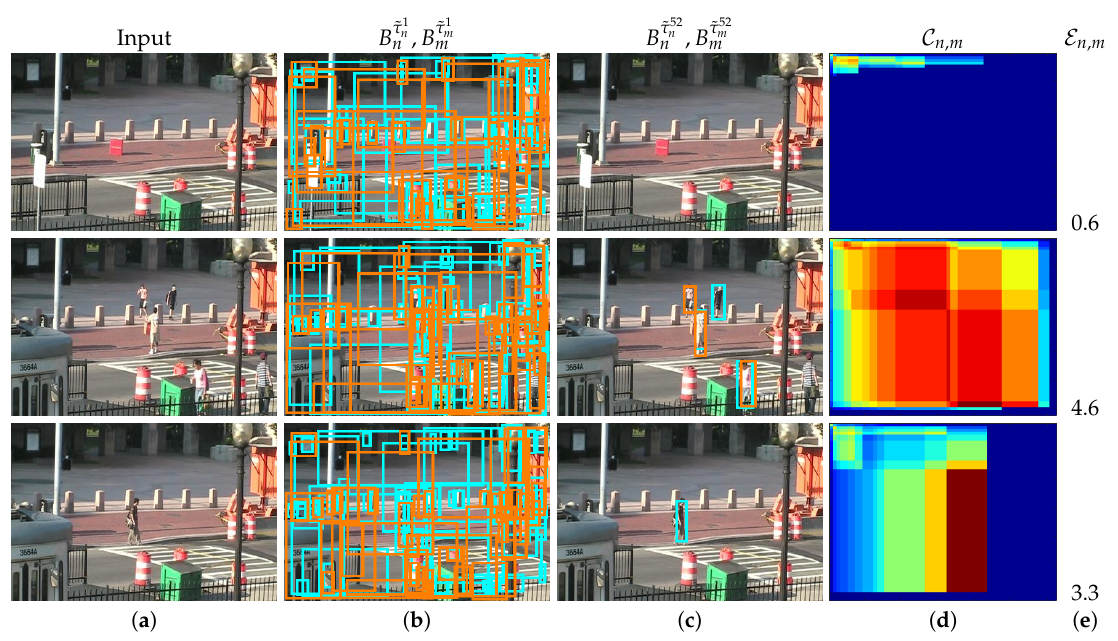
Figure 7. Input images, correlation results, correlation map and entropy results for two Faster R-CNN detectors [1] using VGG (cyan) and ZF models (orange). Three examples (rows) are shown where the column ( a ) are the input images, the next two columns are the obtained bounding boxes for thresholds: (cid:110) (cid:111) j = L = 60 = 0; and ( c ) ˜ τ 52 = 0.85 from the full set ˜ τ j n ( b ) ˜ τ 1 ; ( d ) the correlation map C 1,2 with color code 1 1 j = 1 of (blue) 0 ≤ C 1,2 ≤ 1 (red); and ( e ) the corresponding entropy value E 1,2